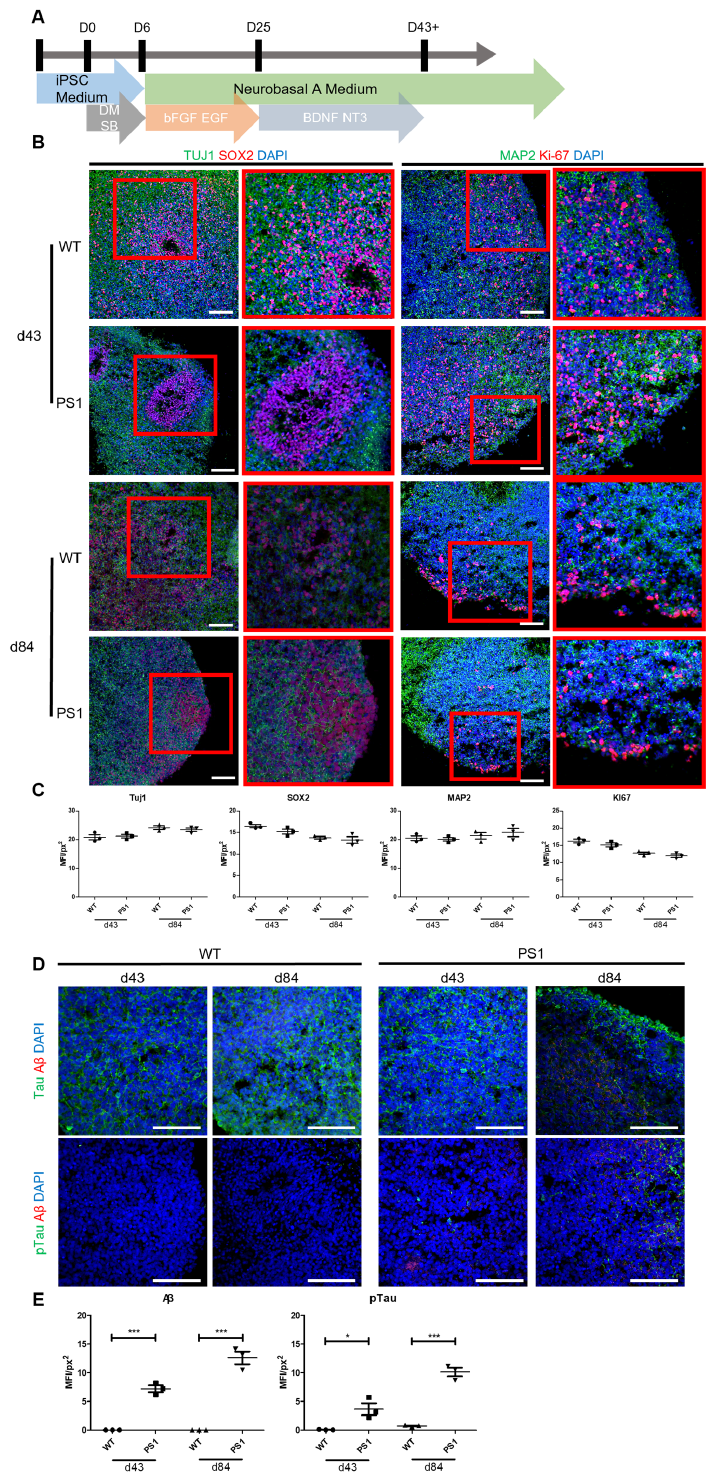
Figure 1. Generation and characterization of WT and PS1 hiPSC-derived cortical brain organoids. ( A ) Schematic image illustrating the timeline of hiPSC-derived cortical brain organoid development. ( B , C ) Representative images of immunostaining for cortical organoid markers Tuj1, SOX2, MAP2 and KI67 in sectioned WT and AD organoids at Day 43 and Day 84 ( n = 3). Scale bar, 100 µ m. ( D , E ) Representative images of immunostaining for AD phenotype-related markers Tau, pTau and A β in sectioned WT and AD organoids at Day 43 and Day 84 (n = 3). Scale bar, 50 µ m. * p < 0.05, *** p < 0.001. The data are presented as the mean ±